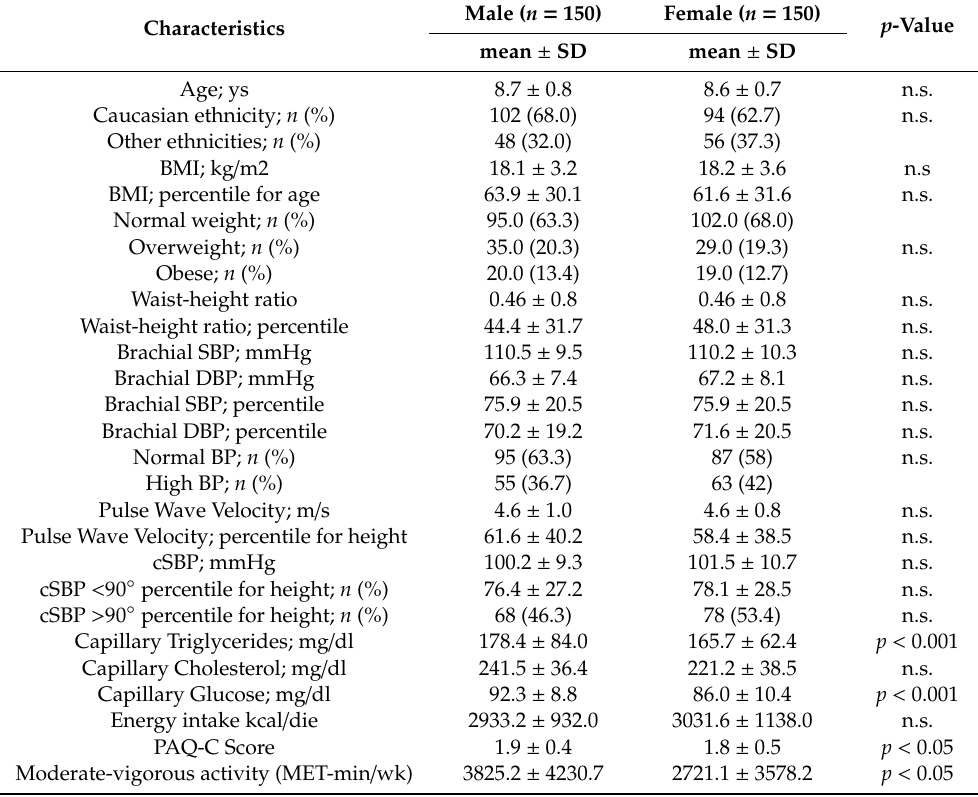
Table 1. General characteristics of the